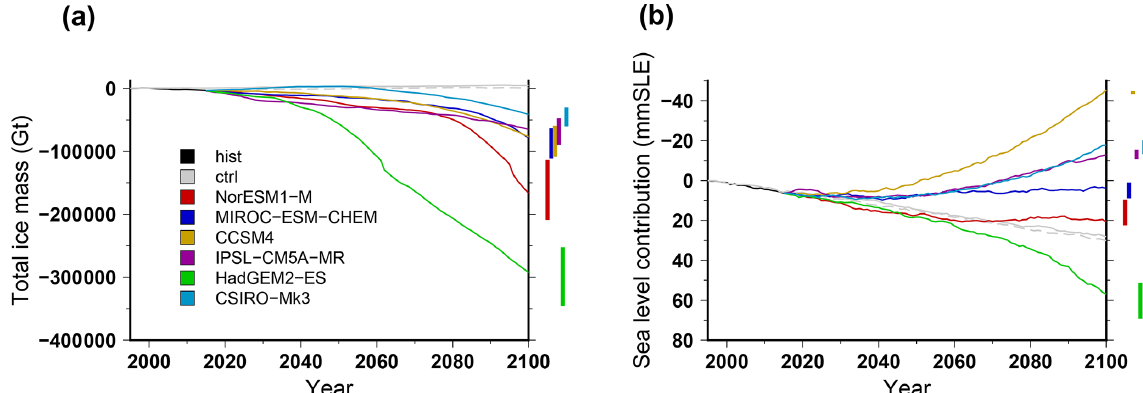
Figure 4. Simulated total ice mass change (a) and ice volume contributing to sea level rise (b) for projections under the different CMIP5 forcings using the RCP8.5 scenario and the medium oceanic sensitivity. The evolutions begin with the historical simulation hist (1995– 2015), and the control experiments ctrl and ctrl_proj are depicted in grey (solid and dashed, respectively). For each projection experiment, the vertical bar shows the minimal and maximal changes associated with the oceanic-forcing sensitivity to temperature change ( low and high ).